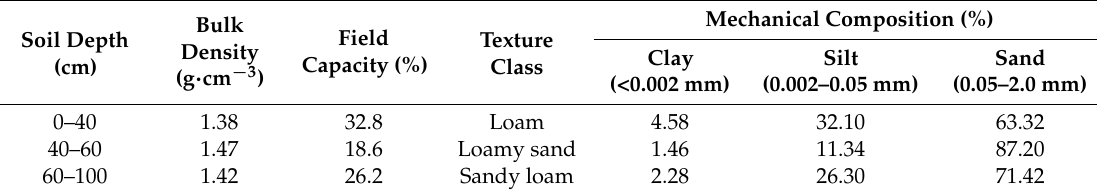
Table 1. Soil physical properties in the experimental region.